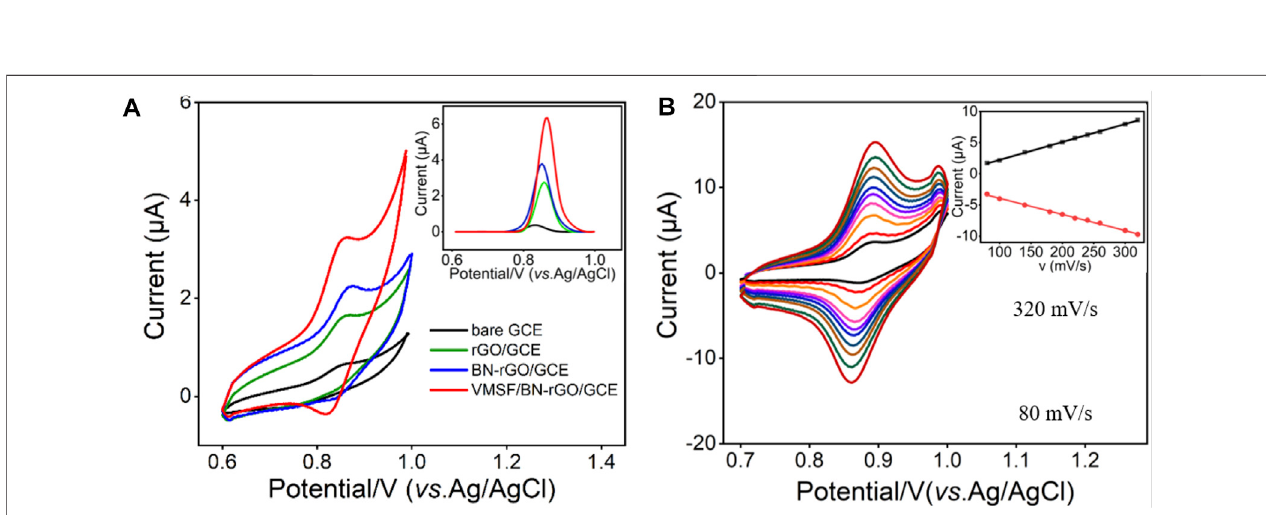
FIGURE 4 | (A) CV curves obtained from the bare GCE, rGO/GCE, BN-rGO/GCE, and VMSF/BN-rGO/GCE electrodes in 0.1 M PBS (pH 6.0) containing 1 μ M CBZ.InsetisthecorrespondingDPVcurves.Thescanratewas50 mV/s. (B) CVcurves of1 μ MCBZin0.1 MPBS(pH 6.0)at theVMSF/BN-rGO/GCEat differentscan rates (80 – 320 mV s − 1 ). The inset is the relationship between the oxidation peak currents and scan rates.